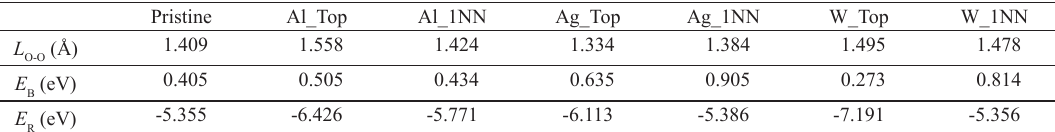
Figure 5. The potential energy surface for O and final state (FS) are shown as solid lines. Table 2. The bond length of O atoms ( L surfaces.